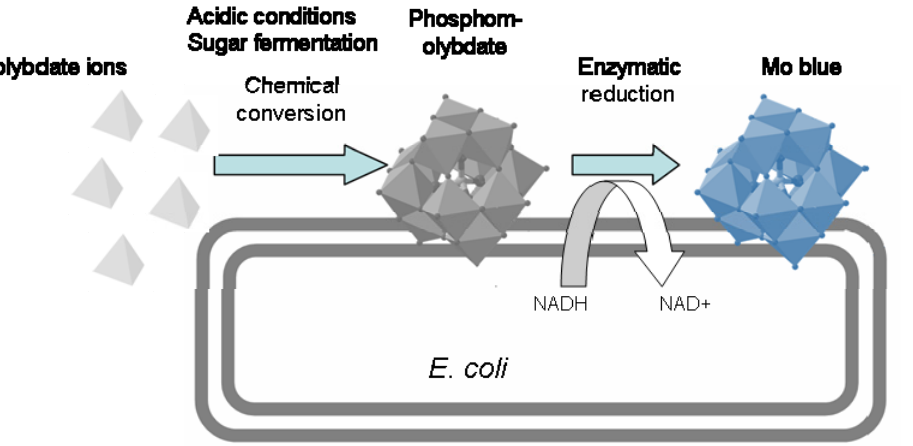
Figure 2. A schematic representation of the probable mechanism of molybdate reduction to molybdenum (Mo)-blue.